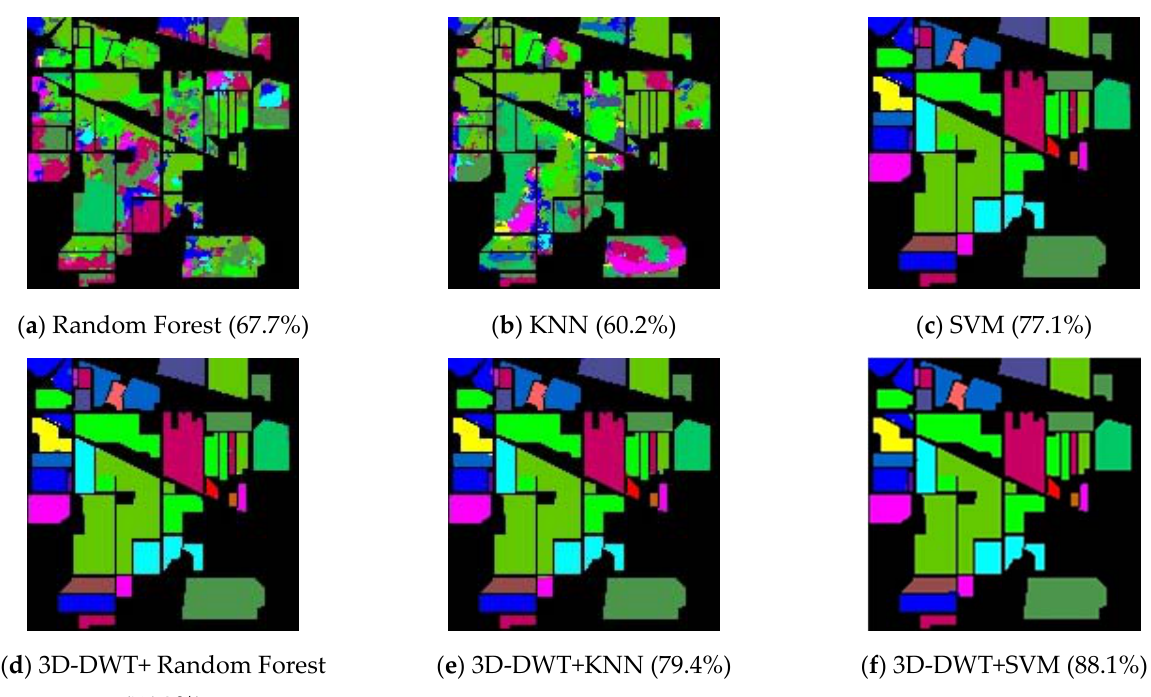
Figure 6. Classification output maps obtained by all computing methods on Indian Pines hyperspectral data (OA are described in parentheses).